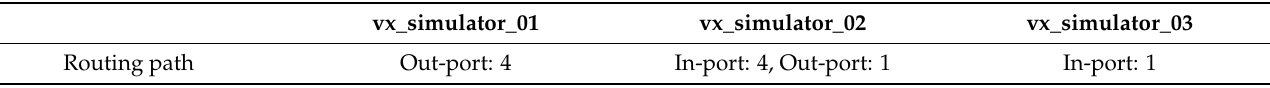
Table 4. The routing path for managing and controlling messages from node vx_simulator_01 to node vx_simulator_02 and node vx_simulator_03, respectively, in the semi-physical platform. vx_simulator_01 vx_simulator_02 vx_simulator_03 Routing path Out-port: 4 In-port: 4, Out-port: 1 In-port: